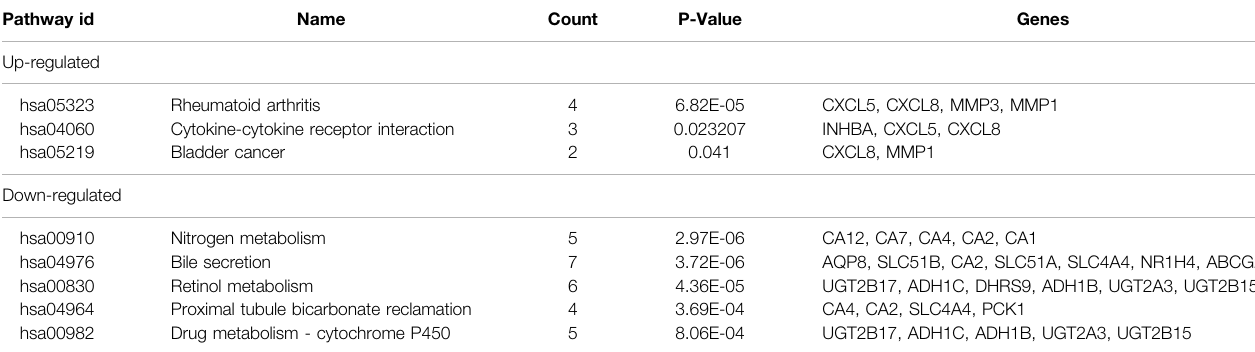
TABLE 4 | The KEGG pathways involved with the common DEGs in